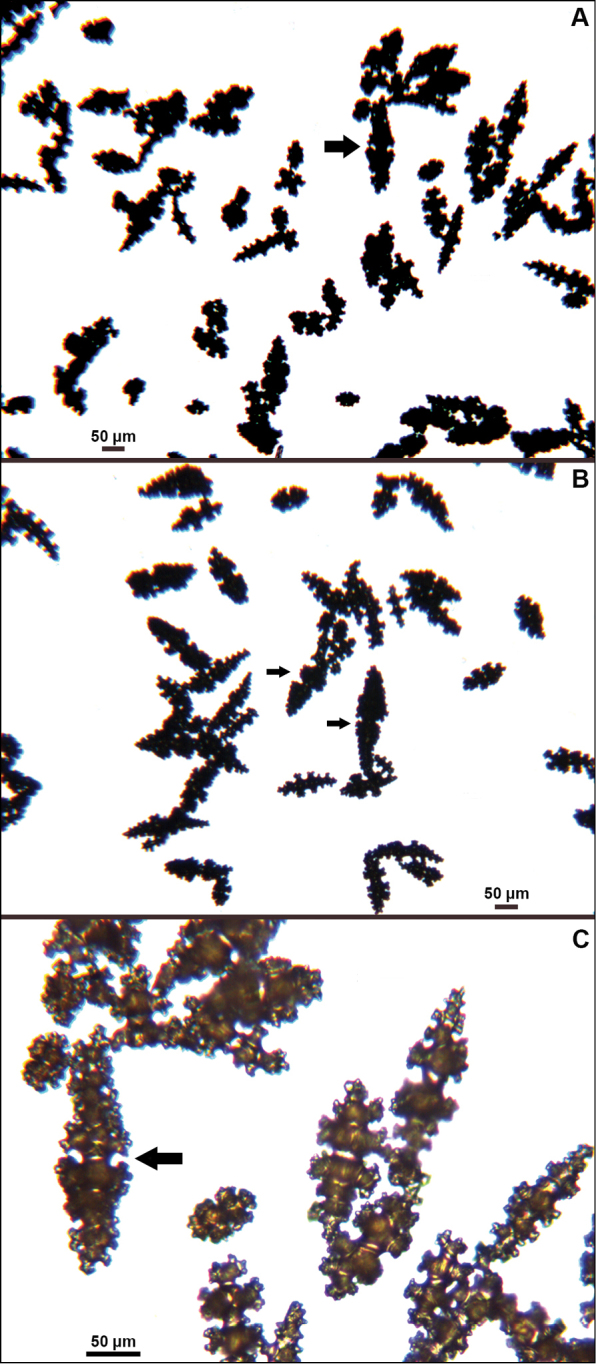
Chromoplexauramarki, SBMNH 423060, light microscopy arrays. A 4× magnification. Note in particular the “triangular-capped” spindle designated with arrow. This sclerite form is never seen in specimens from the genus Swiftia (some species in genus Swiftia can look superficially like this species in overall colony form) B Additional image at 4× magnification of sclerites, illustrating further examples of “triangular-capped” spindles appearing commonly in ChromoplexauramarkiC 10× magnification of sclerites, showing variety, with particularly clear example of the “triangular-capped” spindle, indicated with arrow.